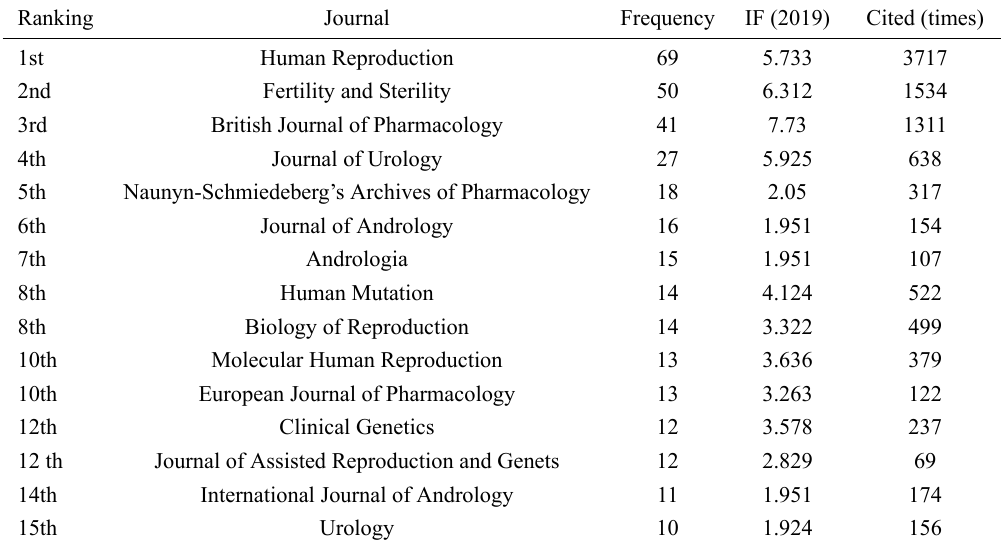
Table 1. The top 15 productive and cited journals on the research of absence of vas deferens. Ranking Journal